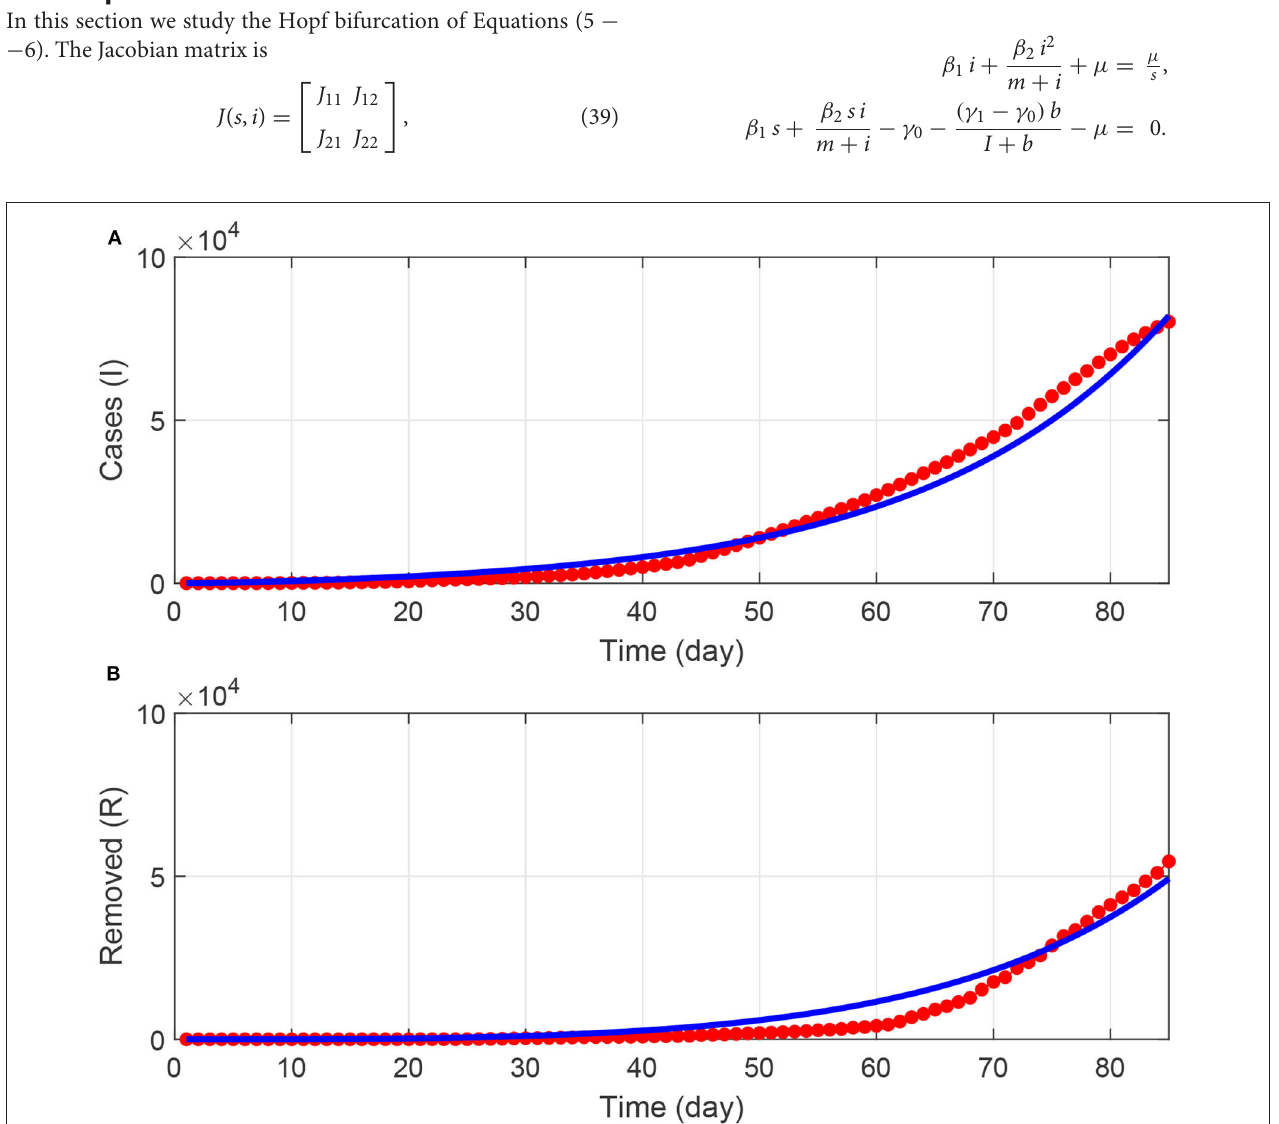
FIGURE 2 | (A,B) Results of fitting the model to COVID-19 data in Saudi Arabia for a period of 90 days starting from March 2, 2020. Blue solid line (model predictions); red points (actual data).